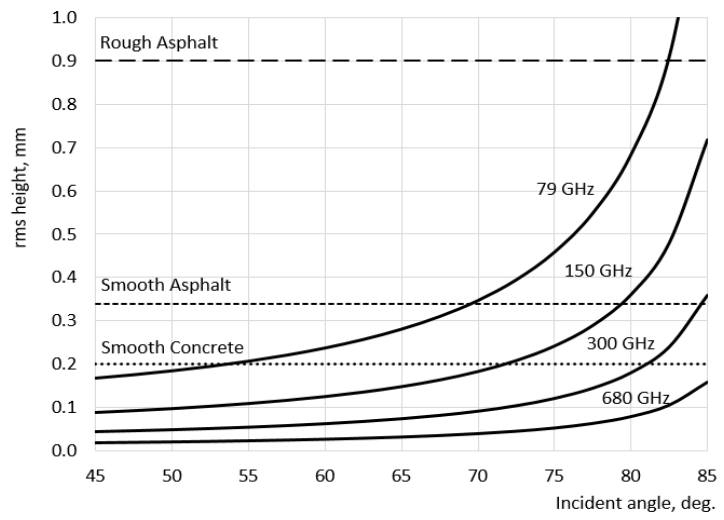
Figure 2. Roughness characterization of road surface as a function of incident angle and radar frequency [31].